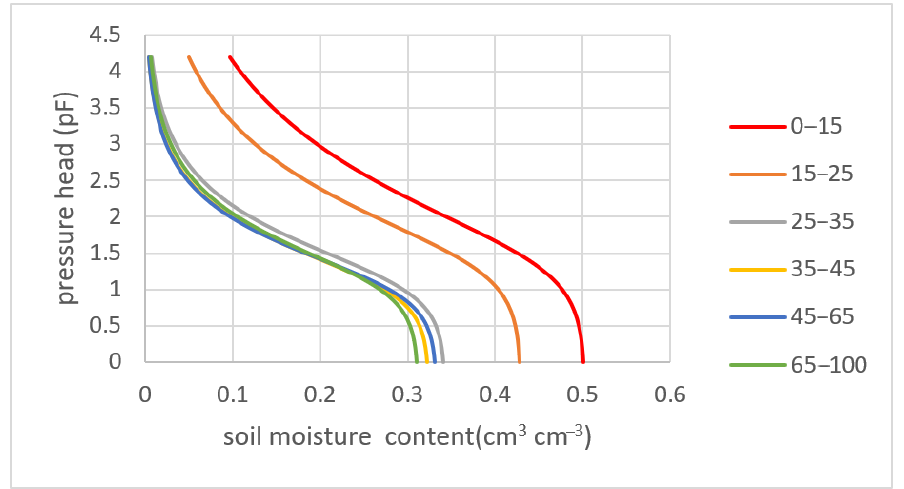
Figure 3. The soil moisture retention curve for the distinguished layers in the analysed soil profile.